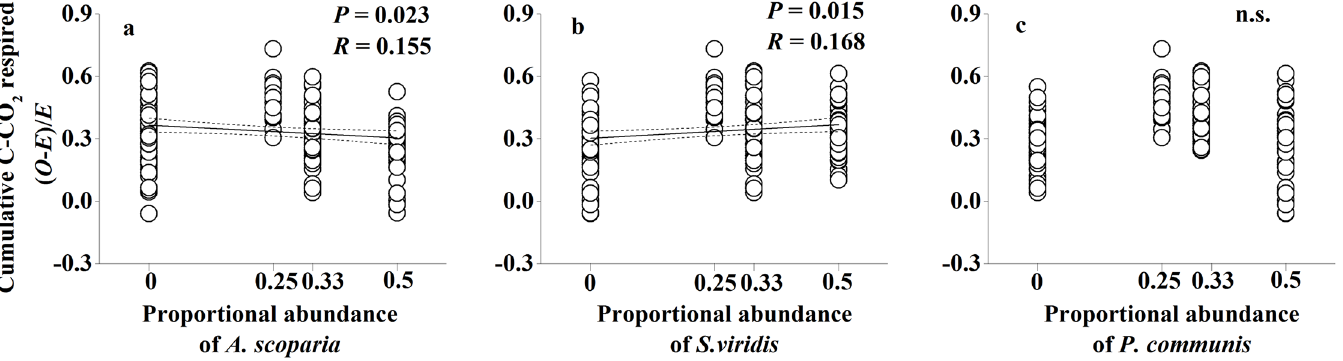
Fig 7. Non-additive soil respiration responses to mixed-species litter as a function of individual species abundance of A . scoparia , S . viridis and P . communis within litter the mixtures. Dashedlines representthe 95% confidenceinterval of the regression. O : observedvalues; E : expectedvalues. n.s.: not